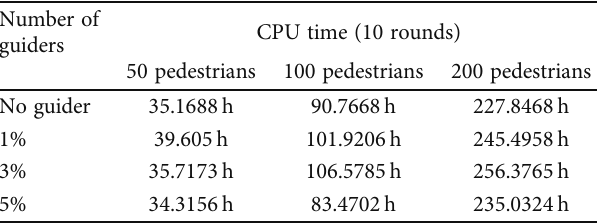
Figure 9: Comparisons of the average number of outside pedestrians in period of time 50s of 0%, 1%, 3%, and 5% guiders situations. (a) 50, (b) 100 and (c) 200 individuals are considered in simulations. The simulation domain is a room with two exits as Figure 3(b). Table 6: CPU time of ten trial runs of 50, 100, and 200 individuals with 0%, 1%, 3%, and 5% guiders in simulations. The simulation domain is a room with two exits as Figure 3(b). The entire time period of a simulation is